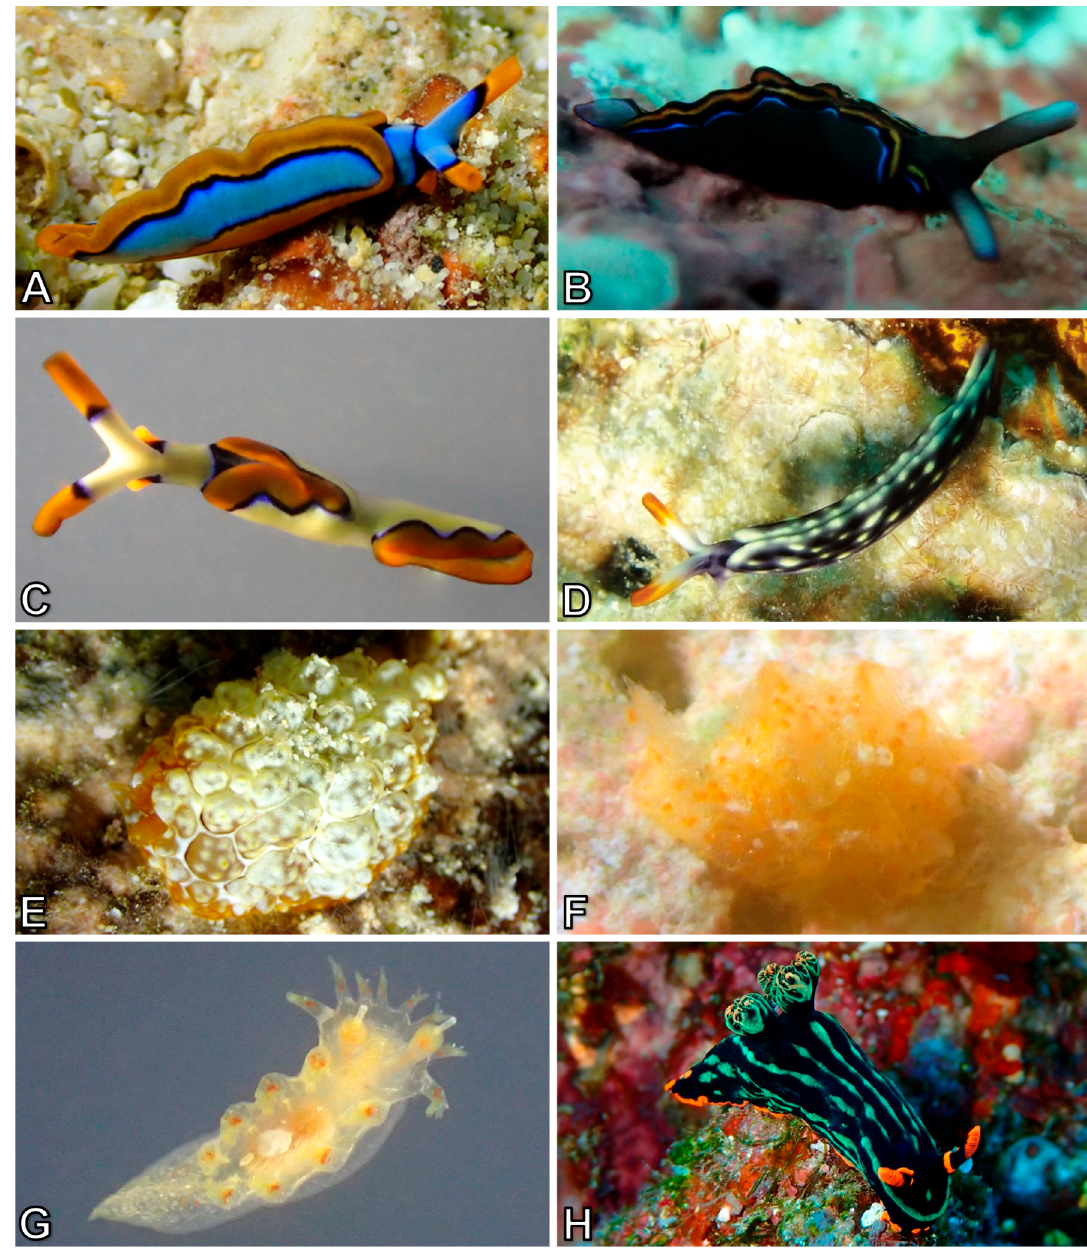
Figure 6. Sacoglossa, Pleurobranchomorpha and Nudibranchia - Doridina: ( A ) Thuridilla lineolata ; ( B ) Thuridilla livida ; ( C ) Thuridilla undula ; ( D ) Thuridilla vataae ; ( E ) Pleurobranchus forskalii ; ( F ) Kaloplocamus spec. ( Kaloplocamus sp. 8 in Gosliner et al. [11]: 116), Kalsp8_16Bu-1; ( G ) Kaloplocamus spec. ( Kaloplocamus sp. 9 in Gosliner et al. [11]: 116), Kalsp9_16Bu-1; ( H ) Nembrotha kubaryana . 3.1.5. Nudibranchia, Anthobranchia (40 species in 21 genera belonging to seven families, Figures